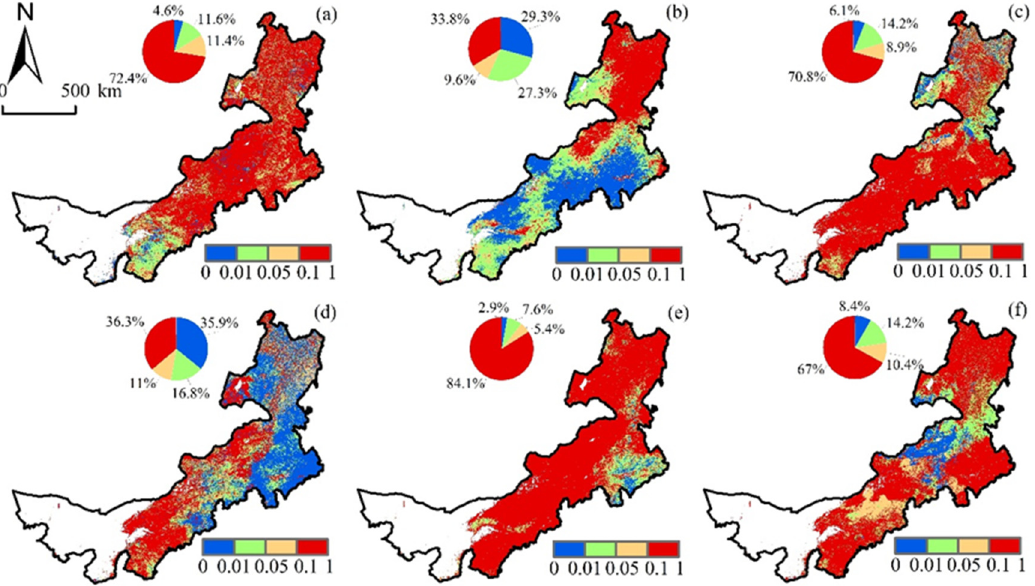
Figure 9. Significance distribution map of eWUE with rainfall and temperature in different seasons.